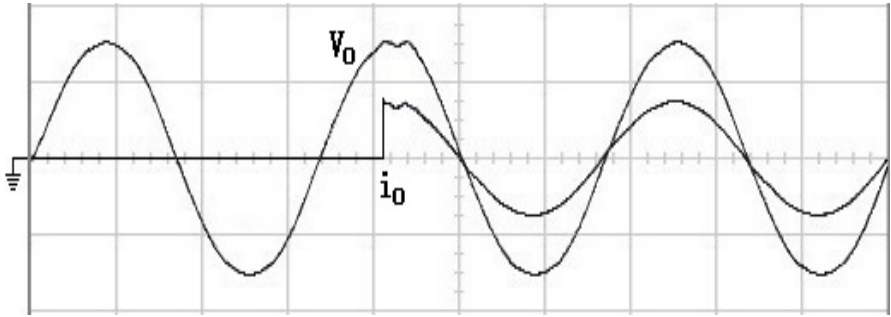
Figure 7. Experimental output waveforms at step-load changing conditions obtained using the proposed approach (vertical: 100 V/division and 20 A/division, horizontal: 5 ms/division).